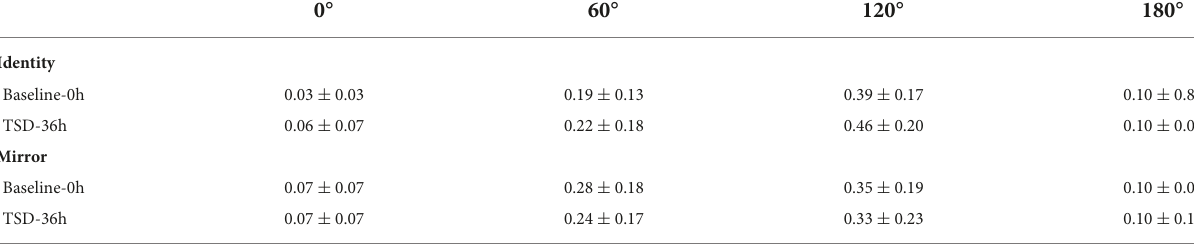
TABLE 3 Mean and standard deviation (SD) for the error rate at baseline and TSD, separate for identical and mirror conditions.